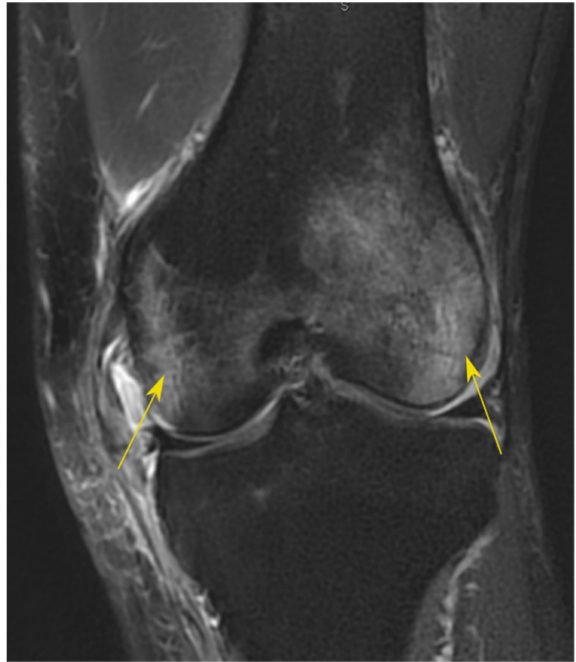
Figure 1. Magnetic resonance image of an extensive bone bruise in femur associated with anterior cruciate ligament